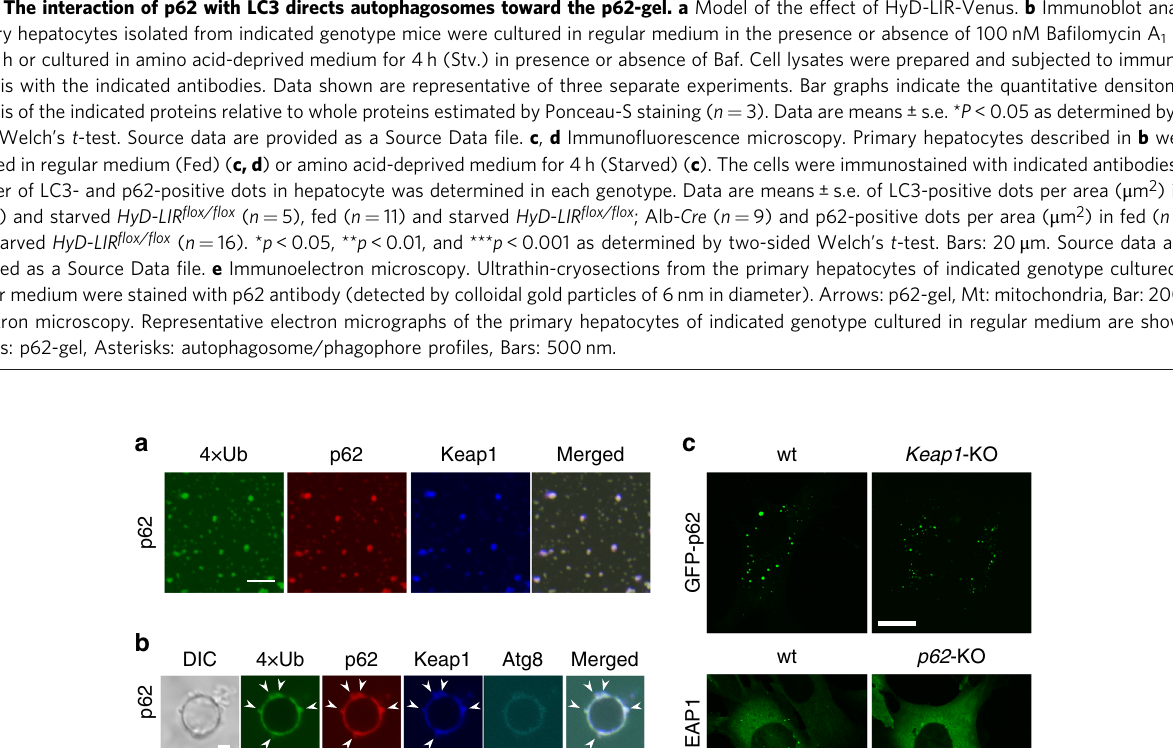
Fig. 5 Localization of Keap1 on the p62-gels. a In vitro formation of p62-4xUb-Keap1 condensates. 5 μ M mCherry-p62, 50 μ M 4xUb, 5 μ M SNAP-4xUb labeled with AlexaFluor 488 and SNAP-Keap1 labelled with Alexa Fluor 647 were mixed and observed by fl uorescence microscopy. Bars: 5 μ m. b Interaction analysis of p62-4xUb-Keap1 condensates with Atg8-GUVs. p62-4xUb-Keap1 condensates as prepared in a were incubated with mKalama1- Atg8-GUVs and observed by fl uorescence microscopy. DIC differential interference contrast. Arrowheads indicate p62-4xUb-Keap1 condensates on the Atg8-GUV. Bars: 2 μ m μ m. c Fluorescence microscopy. Wild-type, p62 - or Keap1 -knockout MEFs were transfected with GFP-p62 or GFP-Keap1. 24 h after the transfection, the cells were observed by confocal microscopy. Bars: 20 μ